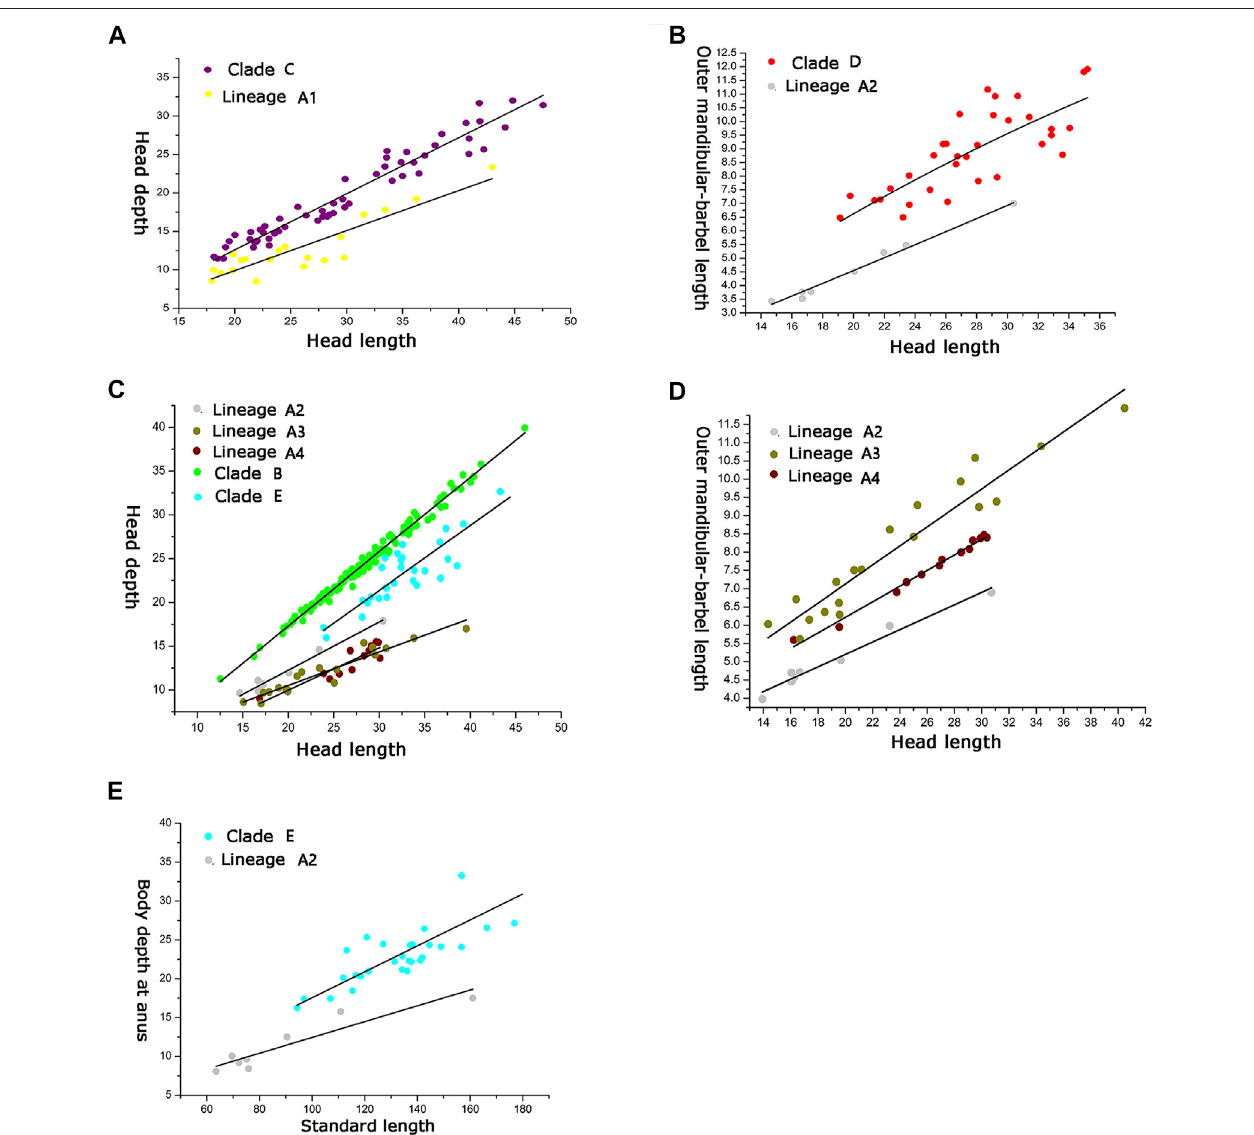
FIGURE 6 | Relation between (A) head depth and HL for Clade C and Lineage A1; relation between (B) outer mandibular barbel length and HL for Clade D and LineageA2;relationamong (C) headdepthandHLforCladesAandB,LineagesA2,A3,andA4;relationamong (D) outermandibularbarbellengthandHLforLineages A2, A3, and A4; relation between (E) body depth at anus and SL for Clade E and Lineage A2.